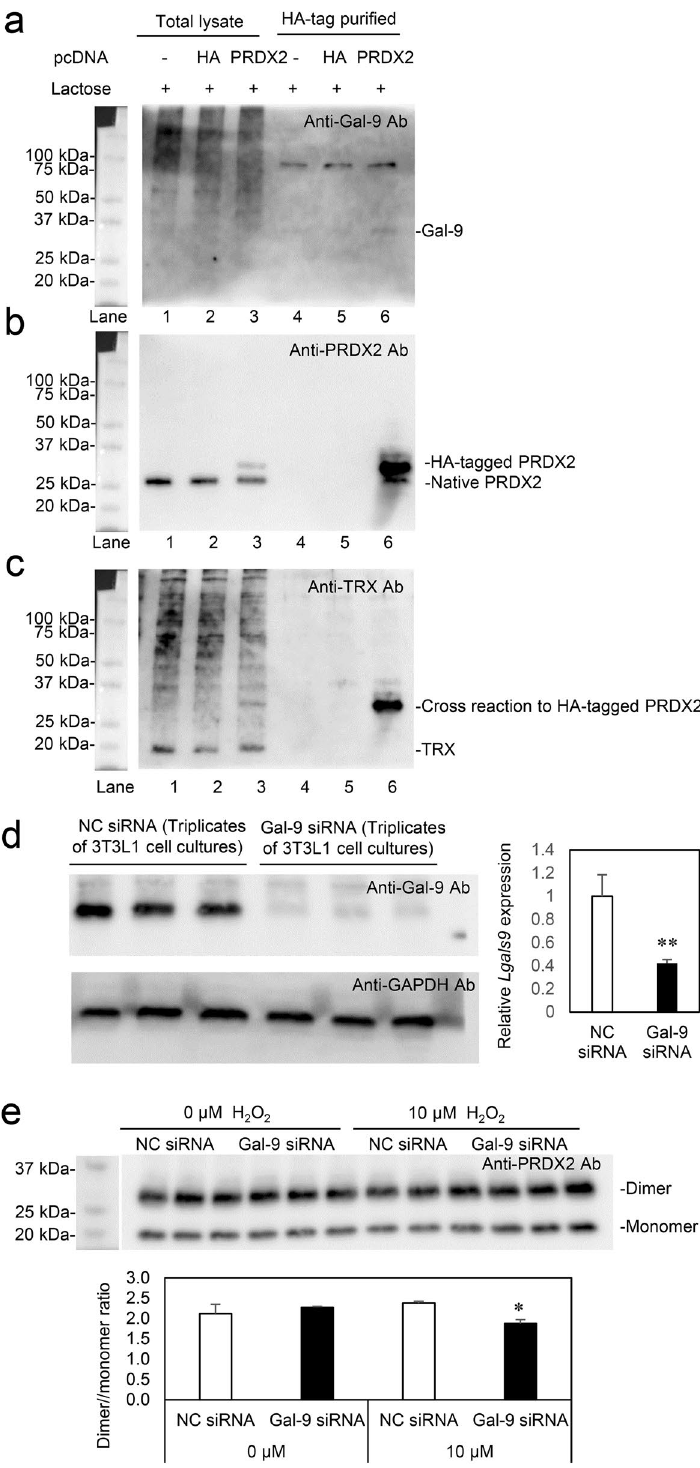
Figure 5. Pull-down assay and Gal-9 siRNA experiments in 3T3L1 cells. ( a ) PRDX2-FLAG-HA-pcDNA3.1 (PRDX2) and FLAG-HA-pcDNA3.1 (HA) were transfected into 3T3L1 cells. In the presence of 0.2 M lactose, the protein complexes were HA-tag purified with Anti-HA tag Beads, and subjected to SDS-PAGE under reducing conditions and Western blot analysis. The membrane was incubated with anti-Gal-9 antibody. ( b ) The membrane was stripped off and incubated with anti-peroxiredoxin 2 (PRDX2) antibody. ( c ) The membranes was again stripped off and incubated with anti-thioredoxin (TRX) antibody. ( d ) 3T3L1 cells were treated with Silencer select Pre-designed siRNA Lgals9 (Gal-9 siRNA) and Silencer select negative control siRNA (NC siRNA) for 40 h. ( e ) After the treatment of 3T3L1 cells with siRNAs, the cells were further cultured in the absence and presence of 10 μM H 2 O 2 for 20 min. *, p < 0.05; **, p < 0.01. Two-pair comparisons by Student’s t